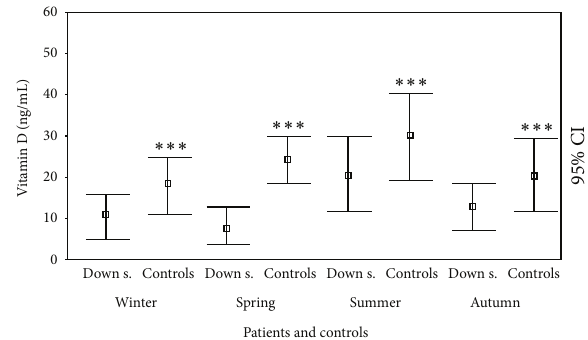
Figure 4: 25(OH)D levels (ng/mL) at cross-sectional evaluation in patients with Down syndrome and controls in different seasons. ∗ 𝑃 < 0.05 ; ∗∗ 𝑃 < 0.005 ; ∗∗∗ 𝑃 < 0.001 .